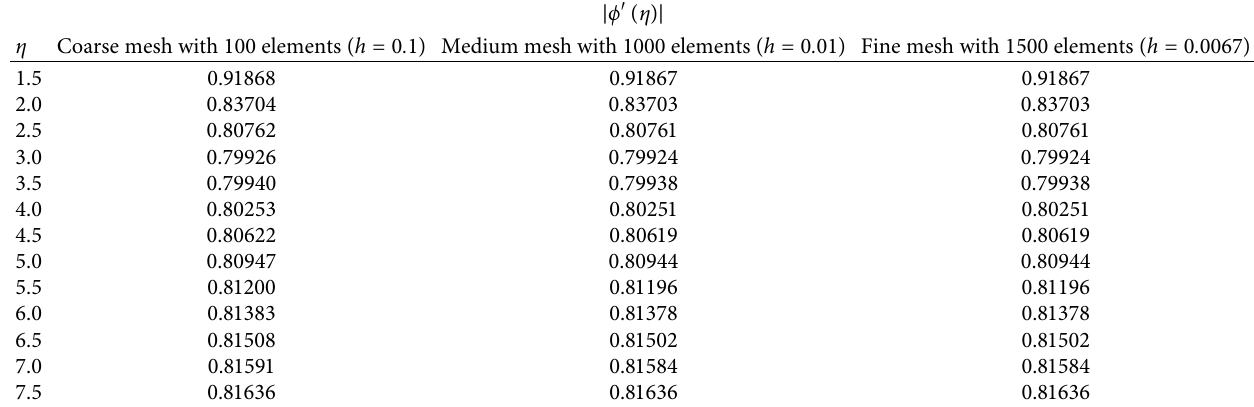
Table 4: Grid-independence test for concentration distribution.